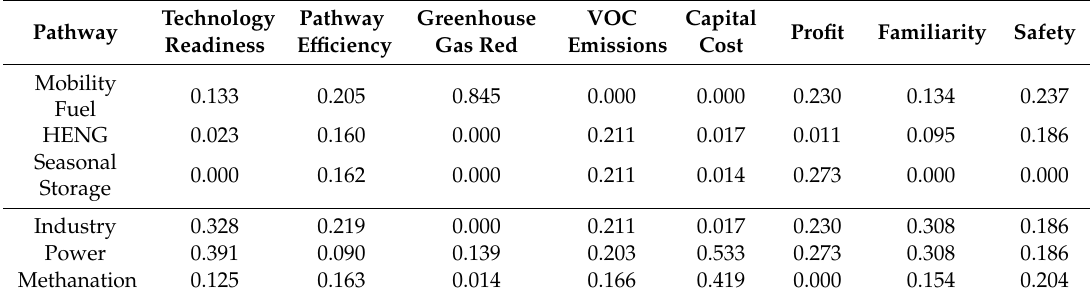
Table 15. Normalized Scores for power-to-gas Pathways.